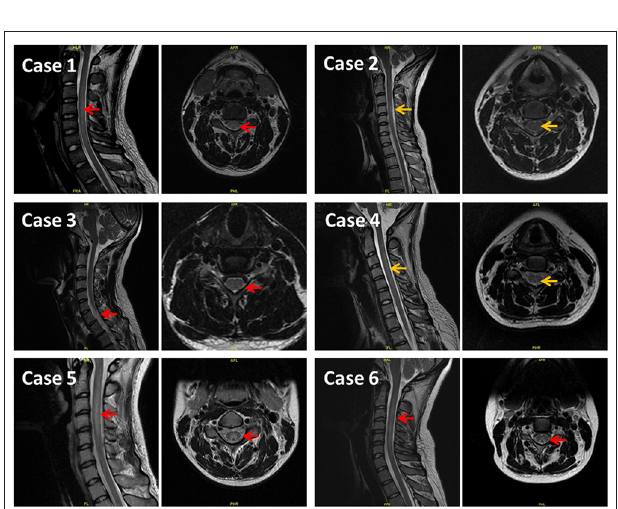
FIGURE 1 | Results of MR T2WI showing high symmetry signal in the cervical spinal posterior cord, presenting splayed or inverted V sign. On the left of each case is sagittal image and on the right is axial image. Red arrows indicate a clearly high signal. Yellow arrows indicate slightly higher or suspicious signals.